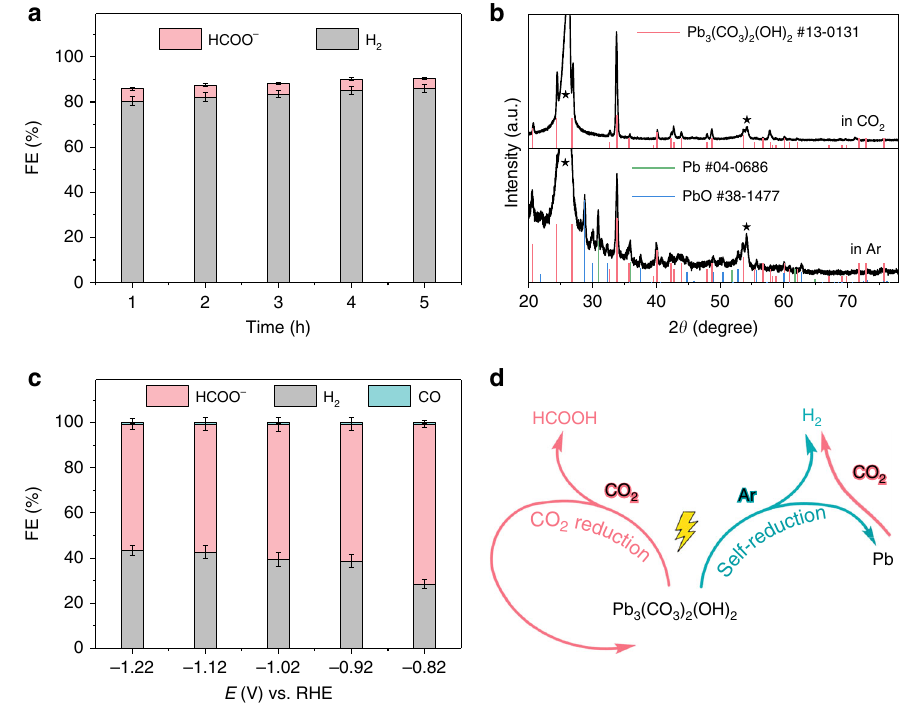
Fig. 5 Performances of hydrocerussite without CO 2 under cathodic potential in NaHCO 3 . a FEs of h-PCOH at − 0.92 V for 5 h in Ar. b Comparison of XRD patterns of h-PCOH after electrolysis under − 0.92 V for 5 h in CO 2 and in Ar. The peaks from the substrate of CP are labelled by black stars. c FEs of tested h-PCOH at different potentials in CO 2 . d Behaviors of hydrocerussite as the cathodic electrocatalyst. Error bars correspond to the standard error of the